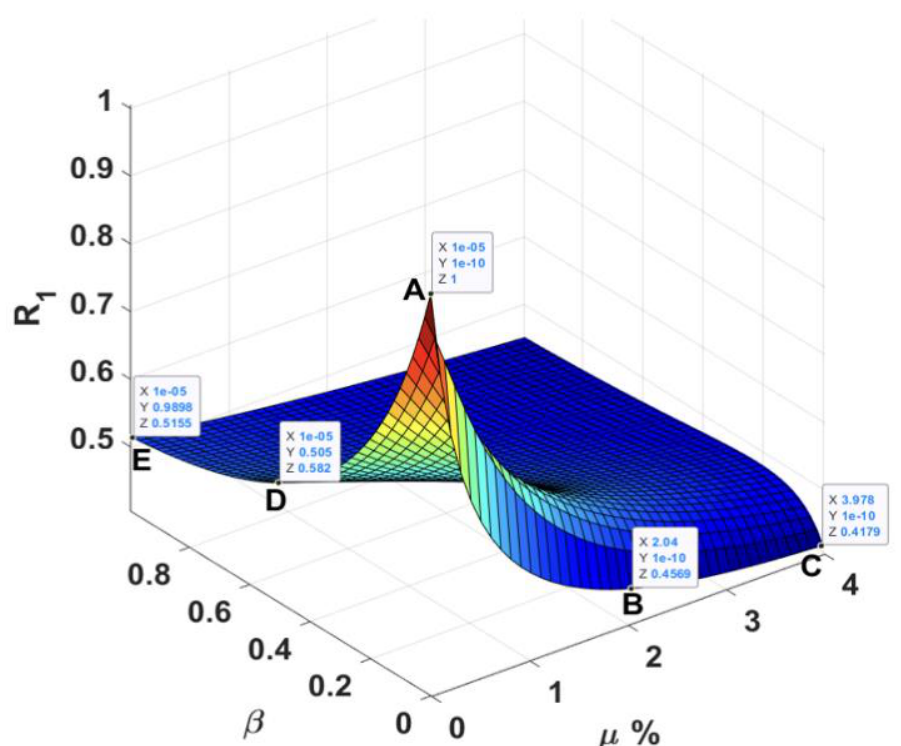
Figure 10. Effect of inertance and mass ratios on the acceleration response under filtered white noise excitations.